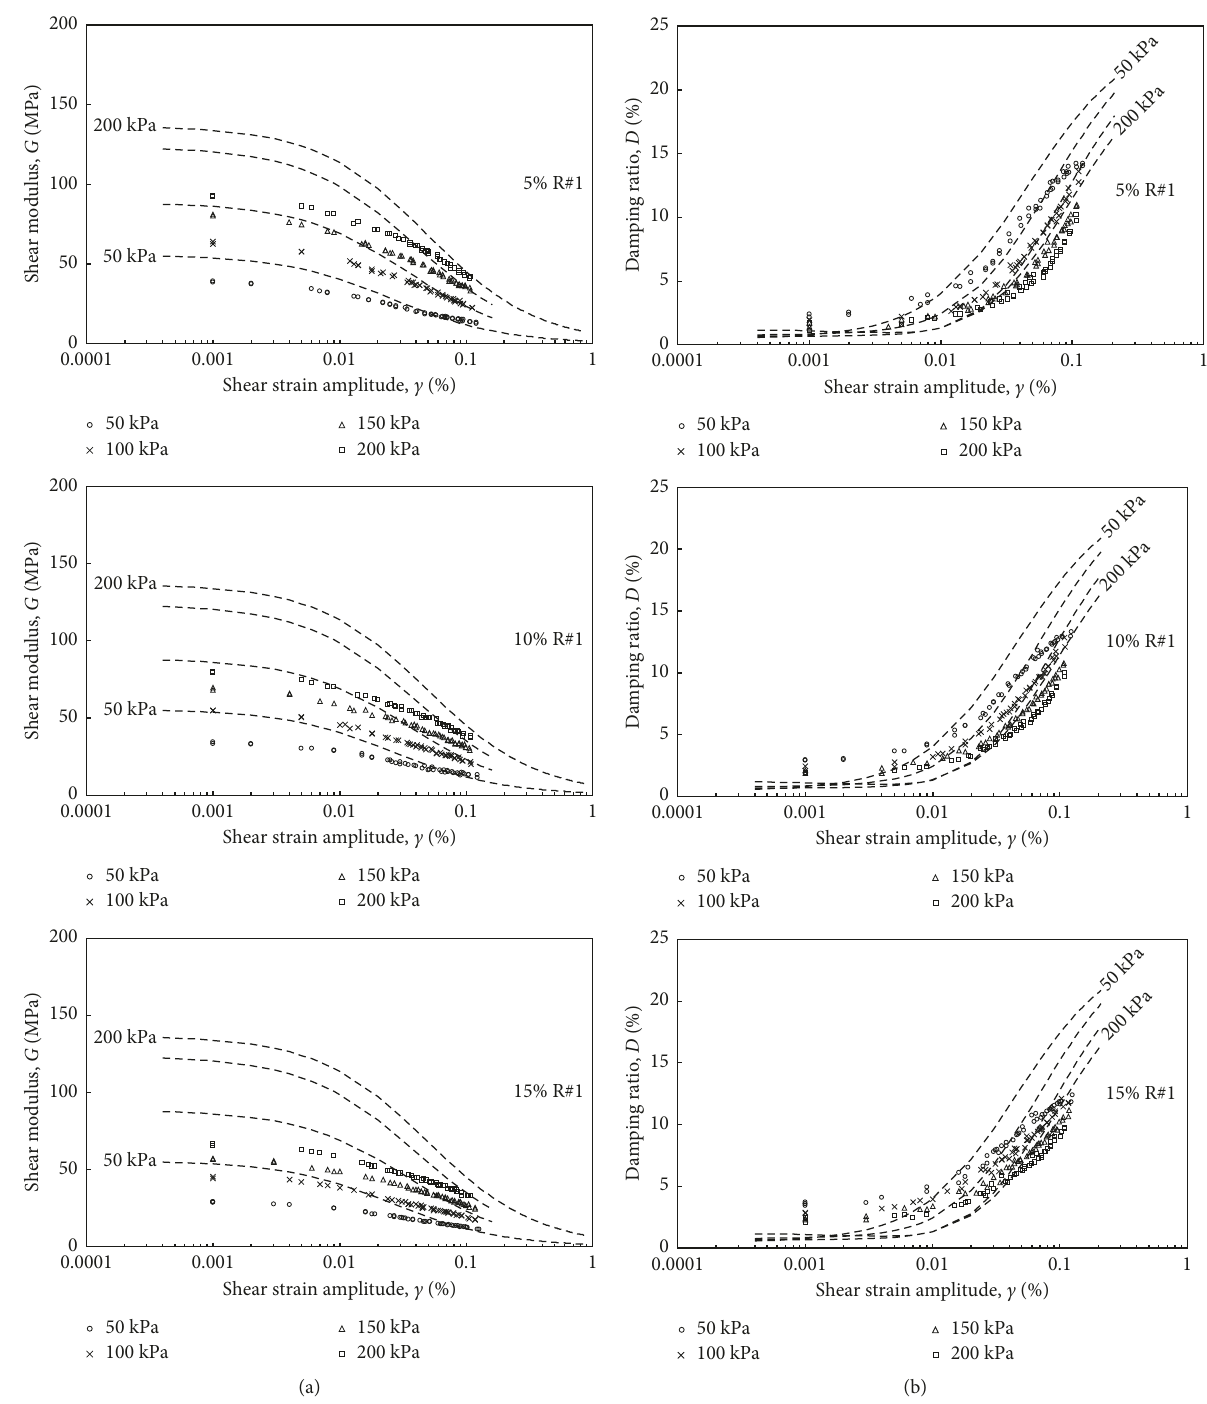
Figure 7: R#1 sand mixture: (a) strain-dependent shear modulus and (b) strain-dependent damping